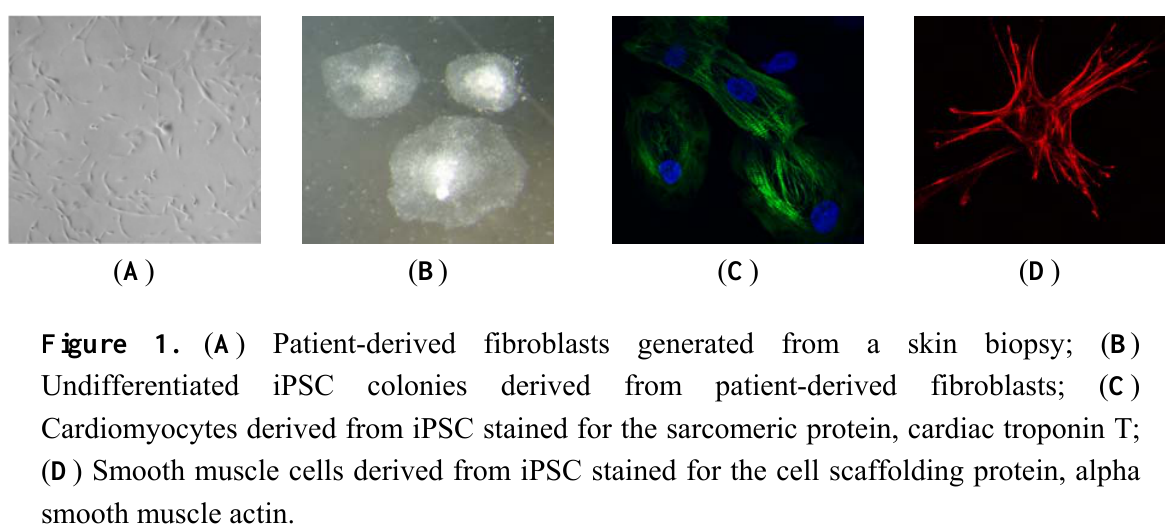
Figure 1. ( A ) Patient-derived fibroblasts generated from a skin biopsy; ( B ) Undifferentiated iPSC colonies derived from patient-derived fibroblasts; ( C ) Cardiomyocytes derived from iPSC stained for the sarcomeric protein, cardiac troponin T; ( D ) Smooth muscle cells derived from iPSC stained for the cell scaffolding protein, alpha smooth muscle